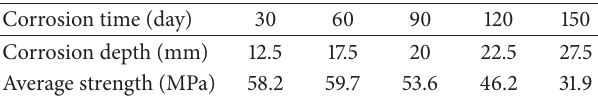
Table 4: Corrosion depth of concrete and its corresponding average strength at each corrosion